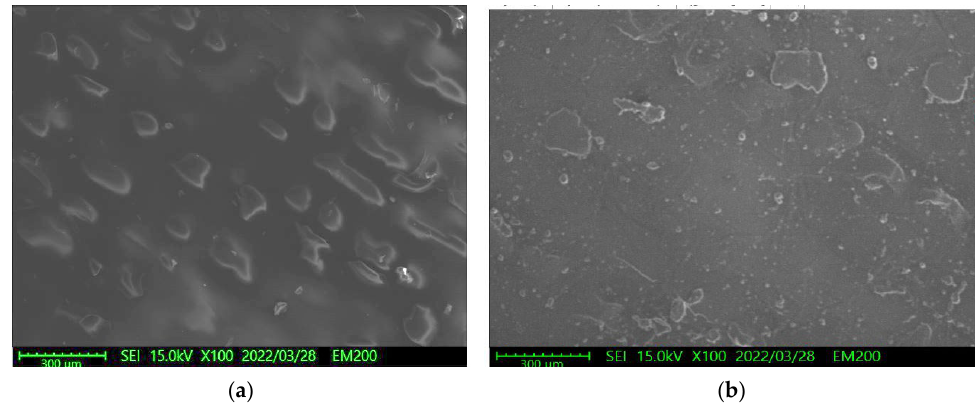
Figure 6. Three-dimensional topographies of the substrate with a Shore A hardness of 95: ( a ) with- out and ( b ) with Parylene C coating.